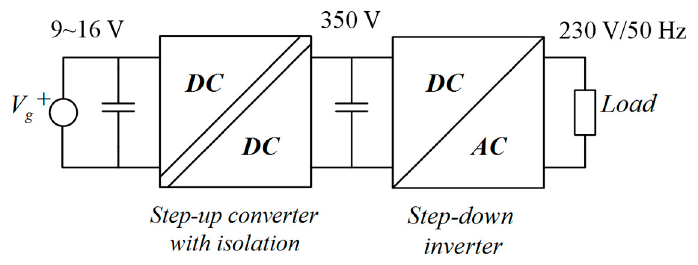
Figure 1. General diagram of the conventional microinverter configuration.